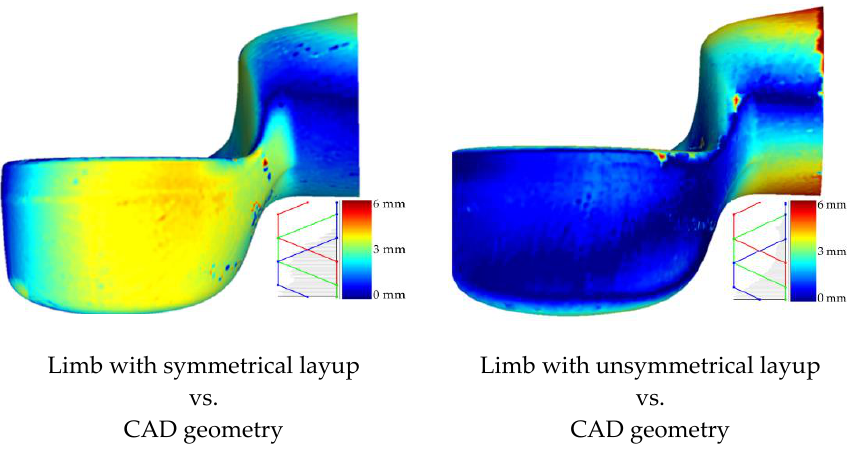
Figure 12. Comparison of two meshes by determination of the Hausdorff distance.